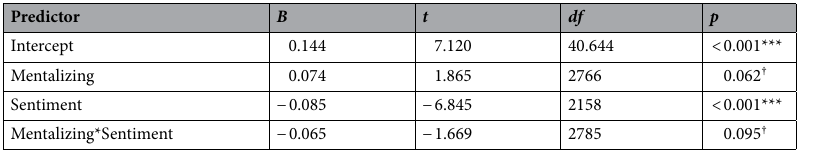
Table 3. Predicting participants’ congruent recommendation rating change from mean activity in mentalizing regions, sentiment of peer recommendations and their interaction (positive coefficients indicate greater change in the direction of the recommendation). † p < 0.10, * p < 0.05, ** p < 0.01, *** p <